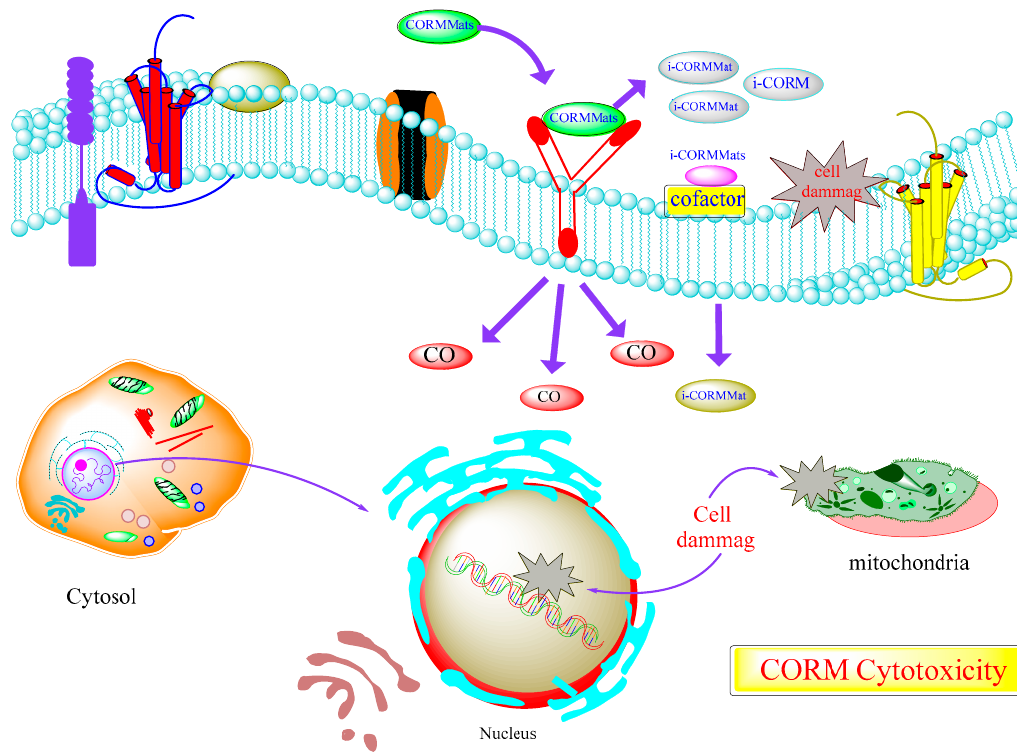
Figure Figure 29. The CORMs/CORMats integration exhibited the cytotoxicity of metal residue (i ‐ CORMs/CORMats).